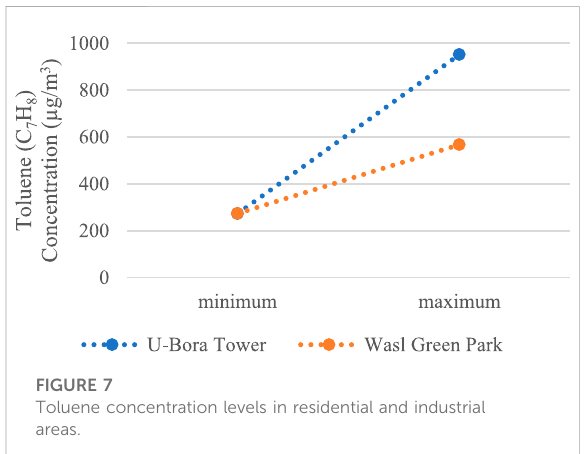
FIGURE 7 Toluene concentration levels in residential and industrial